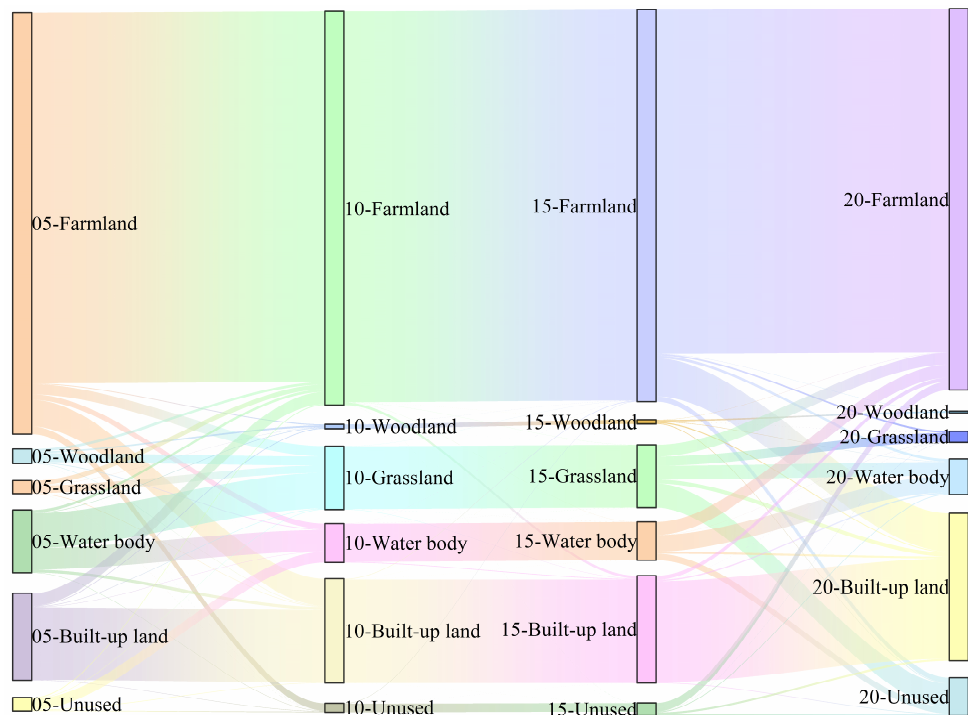
Figure 5. Sankey diagram of the land cover transfer in three-time intervals in Harbin 2005–2020. The rectangular shape refers to transfer between land use types, and the thickness of the curve represents the amount of transfer. The year is indicated by the number before the land use name, where 05 is 2005, 10 is 2010, 15 is 2015, and 20 is 2020.